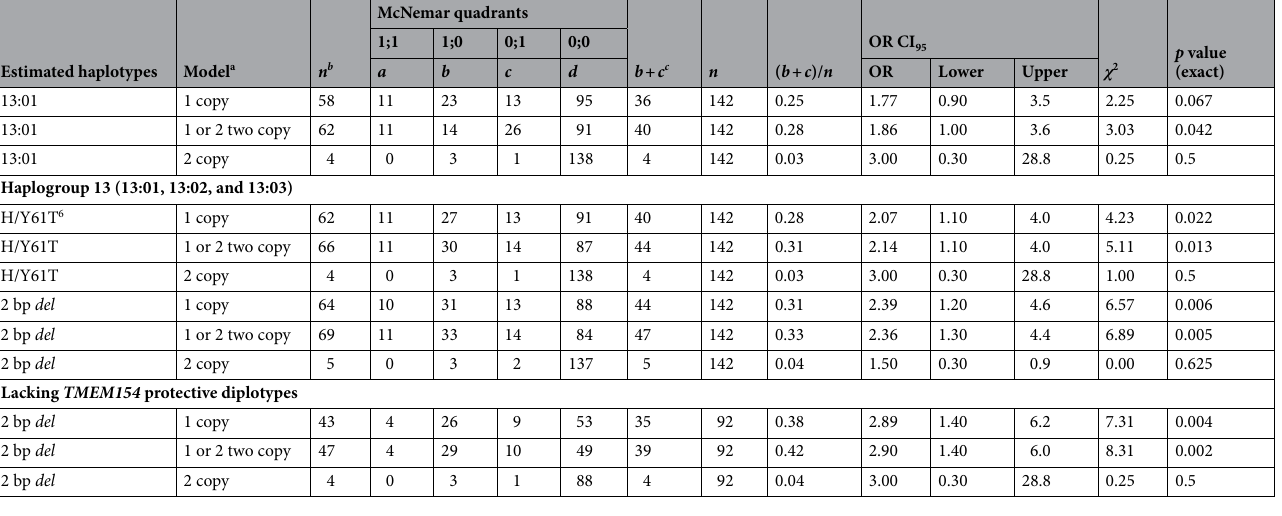
Table 2. McNemar’s statistics of common DRB1 haplotypes and 2 bp del mutation. Table abbreviations: a, indicate the model that is “at least one copy” is dominant and “two copy” is recessive model; b , total number of ewes that are carriers of interested haplotype as one and/or two copies; c , sum of discordant pairs; OR, Odds ratio; χ 2 , the McNemar’s test statistic with continuity correction; d , representing haplogroup 13 (*1301 and *1303).